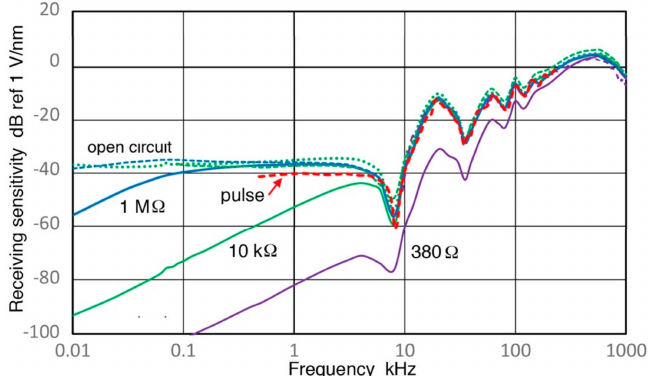
Figure 8. Receiving displacement sensitivity spectra are shown against log-frequency (in kHz) for V189 (0.5) transducer in dB in reference to 1 V/nm using three Z in of 1 M Ω (blue), 10 k Ω (green) and 380 Ω (purple). Corresponding pulse sensitivity spectrum is in red dash curve and calculated open-circuit sensitivities are in blue dot (using data of Z in of 1 M Ω ) and in green dot (10 k Ω ) curves. Third open-circuit sensitivity curve with 380 Ω is plotted but is invisible due to